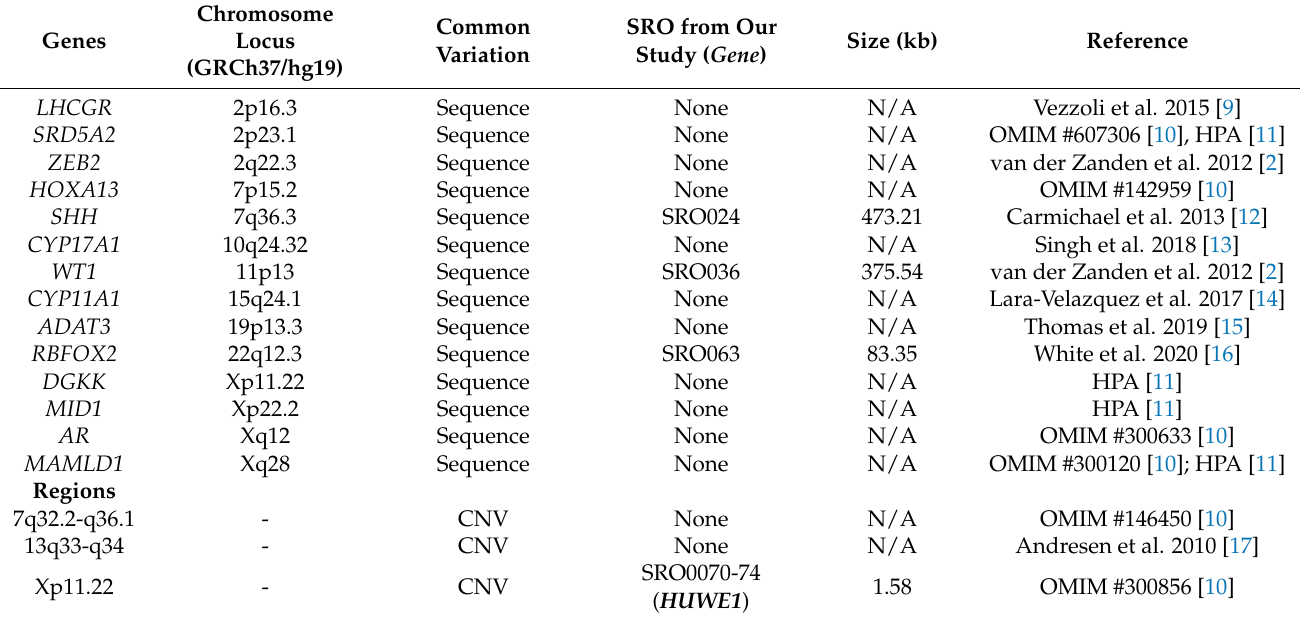
Table 1. Selected previously defined genes and regions in